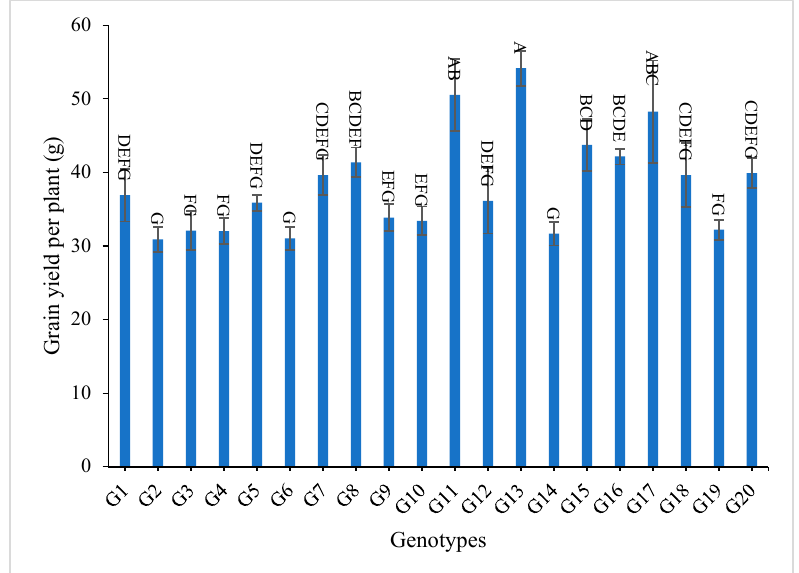
Figure 8. The mean values of grain yield/plant (g) of twenty rice genotypes over the two years. Bar represents the standard deviation. Different alphabetic letters represent the significant differences among the genotypes at p < 0.05, based on Duncan’s multiple range test. Table S6 and Figure 9 reveal the data of the traits hulling %, milling % and amylose content % for the two-year and combined data. The genotypes G7, G15, G1, G12 and G10 showed the highest values of hulling percentage for the two-year and combined data, respectively, as shown in Table S6. However, the genotypes G9, G14, G6, G17, G4, G3, G18, G15, G13, G7, and G10 recorded the highest values of milling percentage, as shown in Table S6 and Figure 9. For amylose content percentage, the following five genotypes showed desirable values that ranged between low or intermediate values for the com- bined data over two years: G1 (16.52), G2 (17.87), G13 (18.04), G11 (19.63), and G8 (21.40), as shown in Table S6.